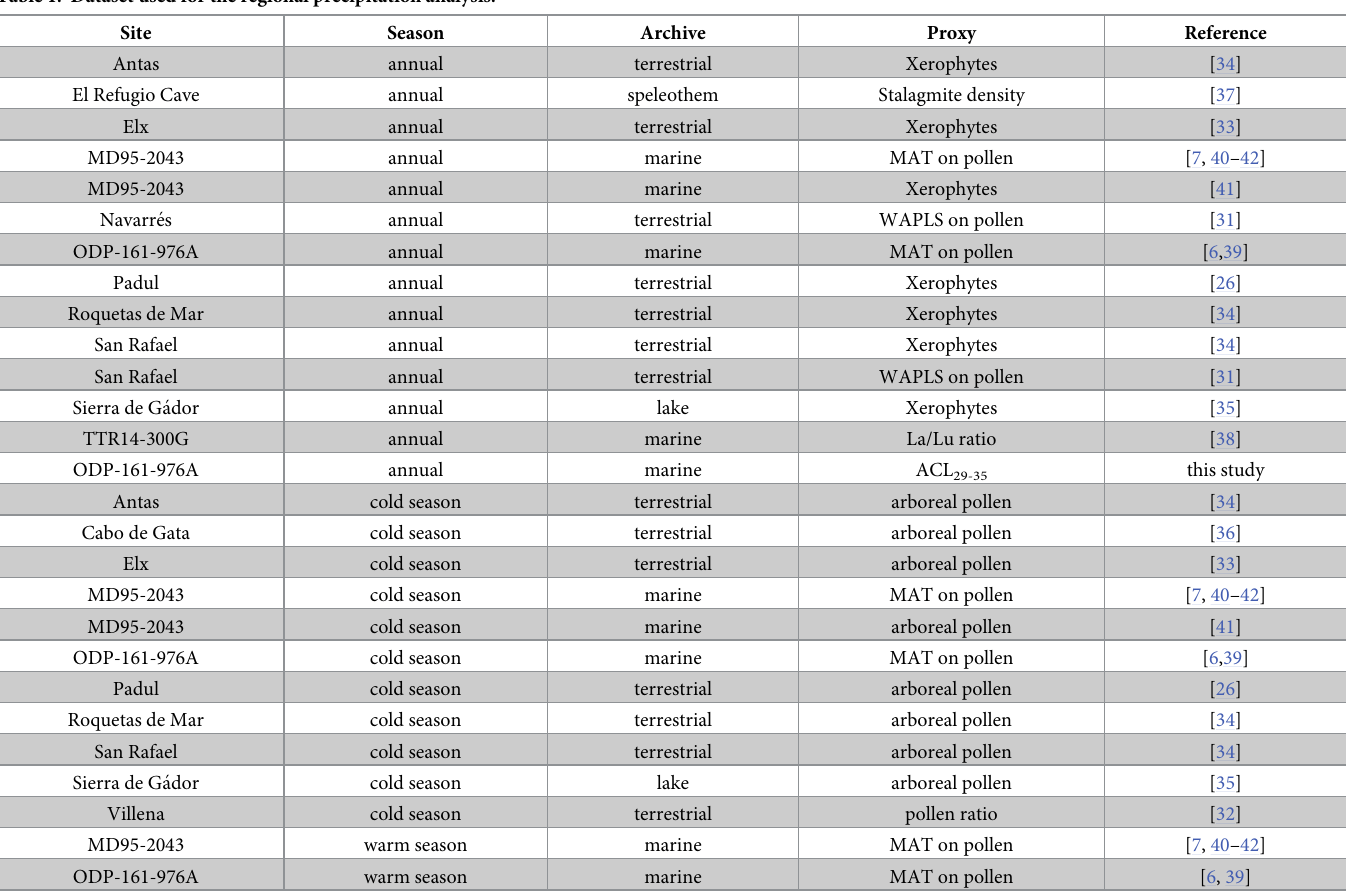
Table 1. Dataset used for the regional precipitation